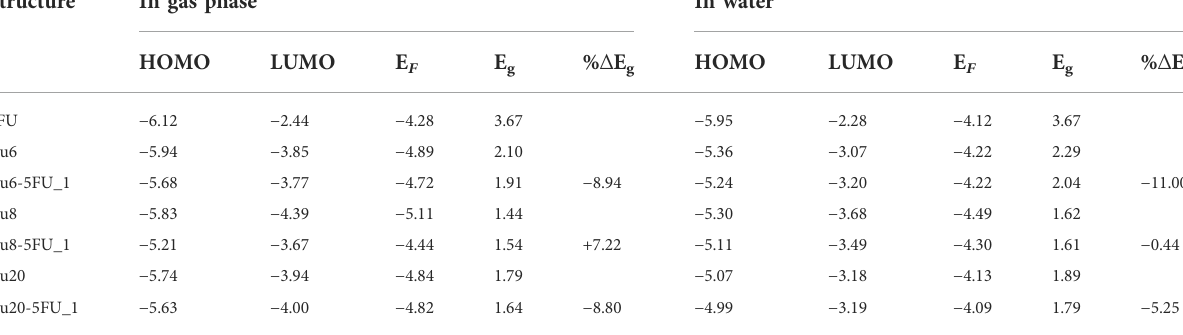
TABLE 2 Energies (eV) of frontier orbitals (HOMO and LUMO), their band gap (Eg) and change of Eg upon 5FU adsorption on gold clusters. Structure